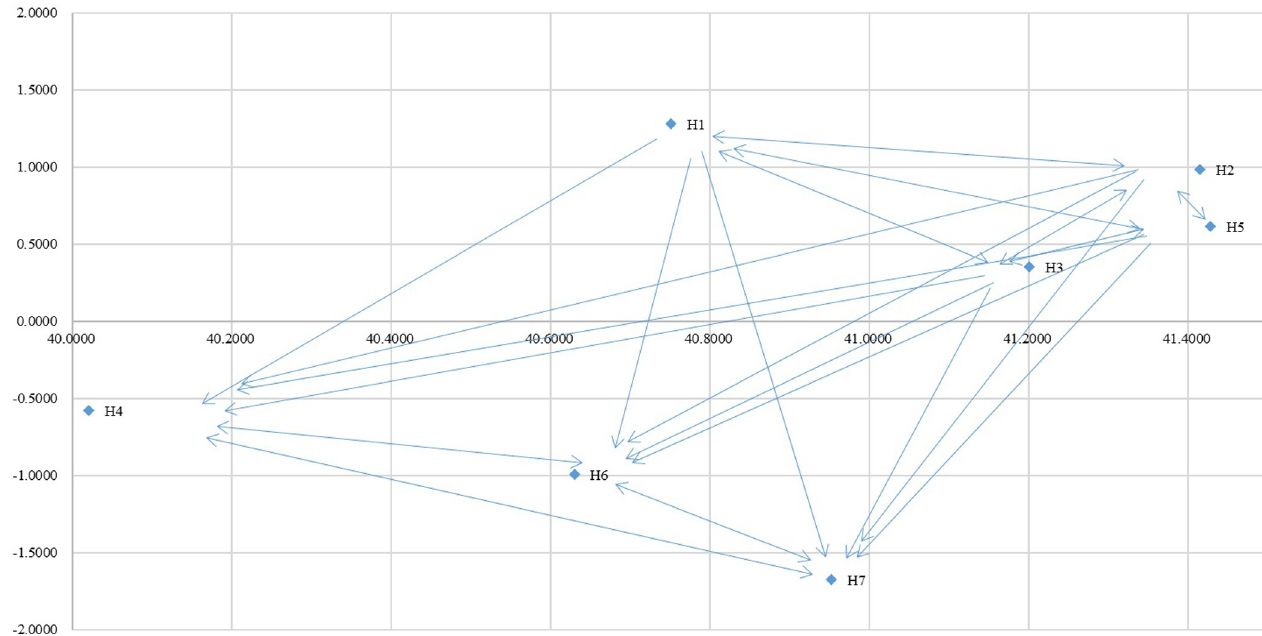
Fig 3. Network relationship map of influences among factors of M-DEMATEL. Budget (H1); Communication channel (H2); Benefits associated with participant (H3); Administration and management (H4); Leadership (H5); Self-efficiency (H6); Skills and Resources (H7).